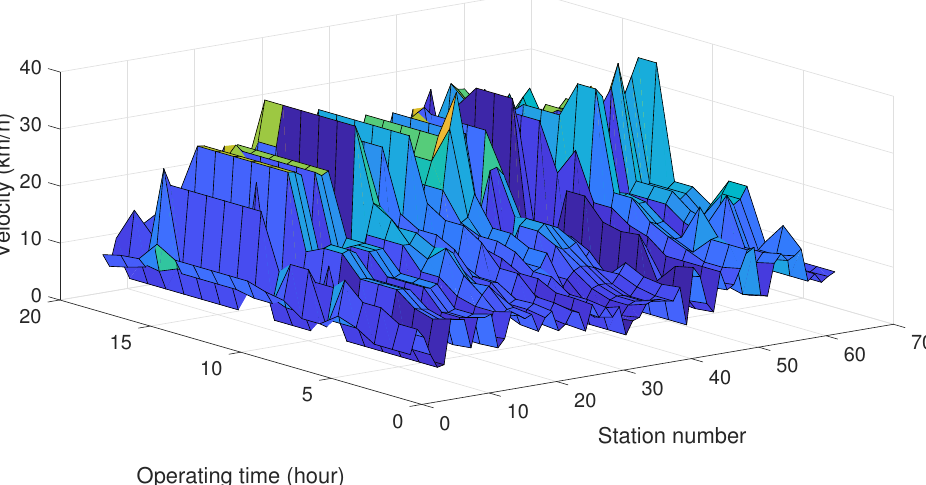
Figure 3. Velocity profile of NYC Metropolitan Transportation Authority (MTA) M1